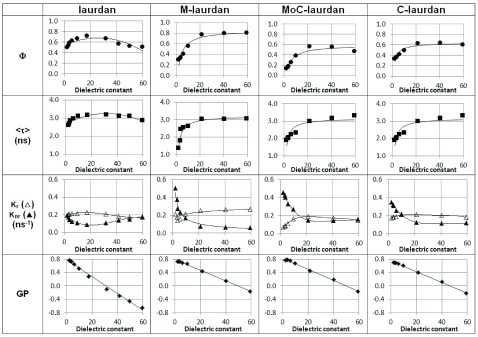
Photophysical characteristics in dioxane/water mixtures.Spectroscopic properties of the four probes in dioxane/water mixtures covering a dielectric constant range from 2 to 60. Quantum yields and mean lifetimes were measured. Deexcitation constants k
r (Δ), k
nr (▲) and Generalized Polarization GP were calculated.